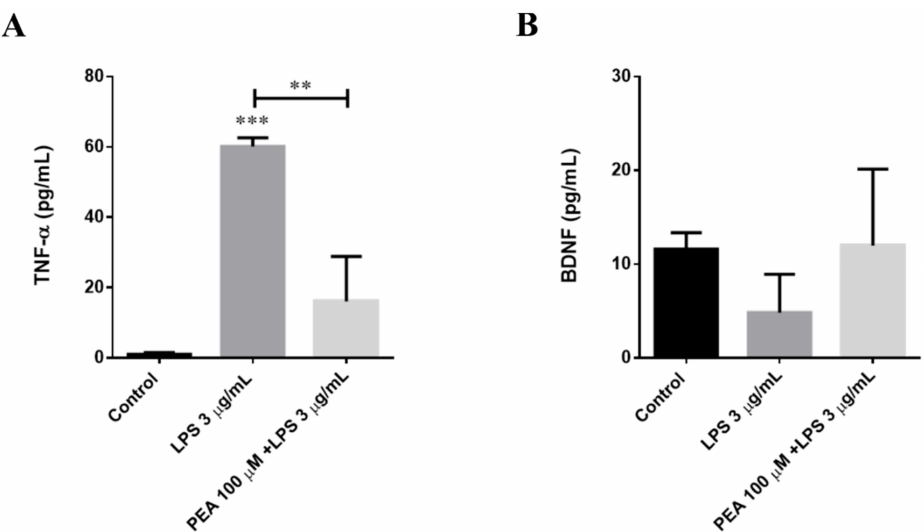
Figure 10. Release of TNF- α ( A ) and BDNF ( B ) at 6 h after LPS application. The mouse primary cortical cultures were incubated with 100 µ M PEA at 1 h before treatment with 3 µ g/mL LPS. The amount of TNF- α and brain derived neurotrophic factor (BDNF) released into the culture medium was quantified after 6 h from LPS treatment. Data are shown as the mean ± S.E.M. of measurements obtained in three independent experiments ( n = 3). Differences between groups were tested for significance by applying the ANOVA test and Tukey post hoc test. ** p < 0.01, *** p <